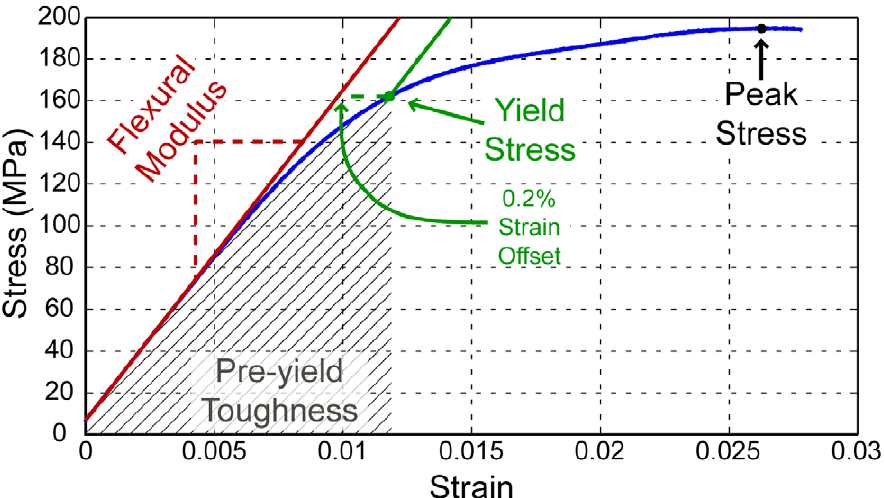
Figure 6. A representative stress vs. strain curve for cortical bone is shown (blue) along with graphical depictions of mechanical parameters. Flexural modulus is the slope of the initial linear mechanical response, yield stress is defined at 0.2% offset from the flexural modulus line, and peak stress is the maximum observed stress. Pre-yield toughness (see text for definition) is proportional to the area under the curve, up to the yield